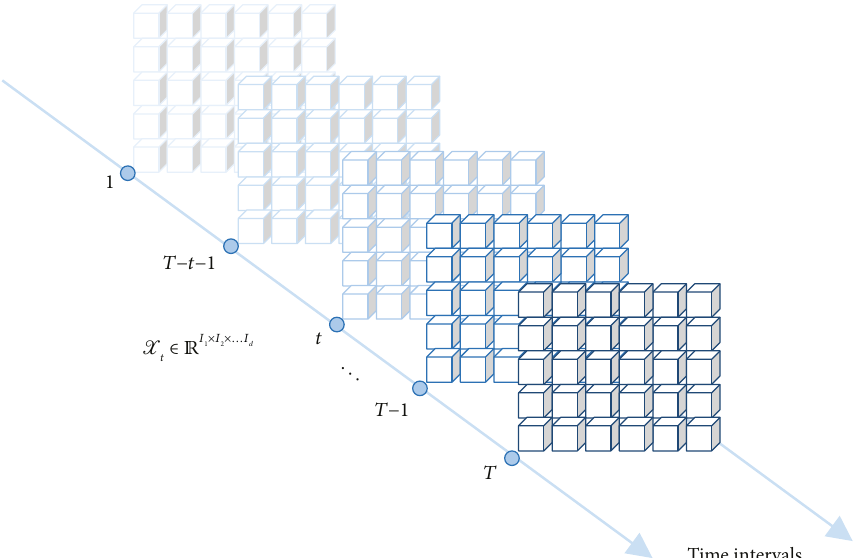
Figure 1: The schematic diagram of a d th -order tensor stream.